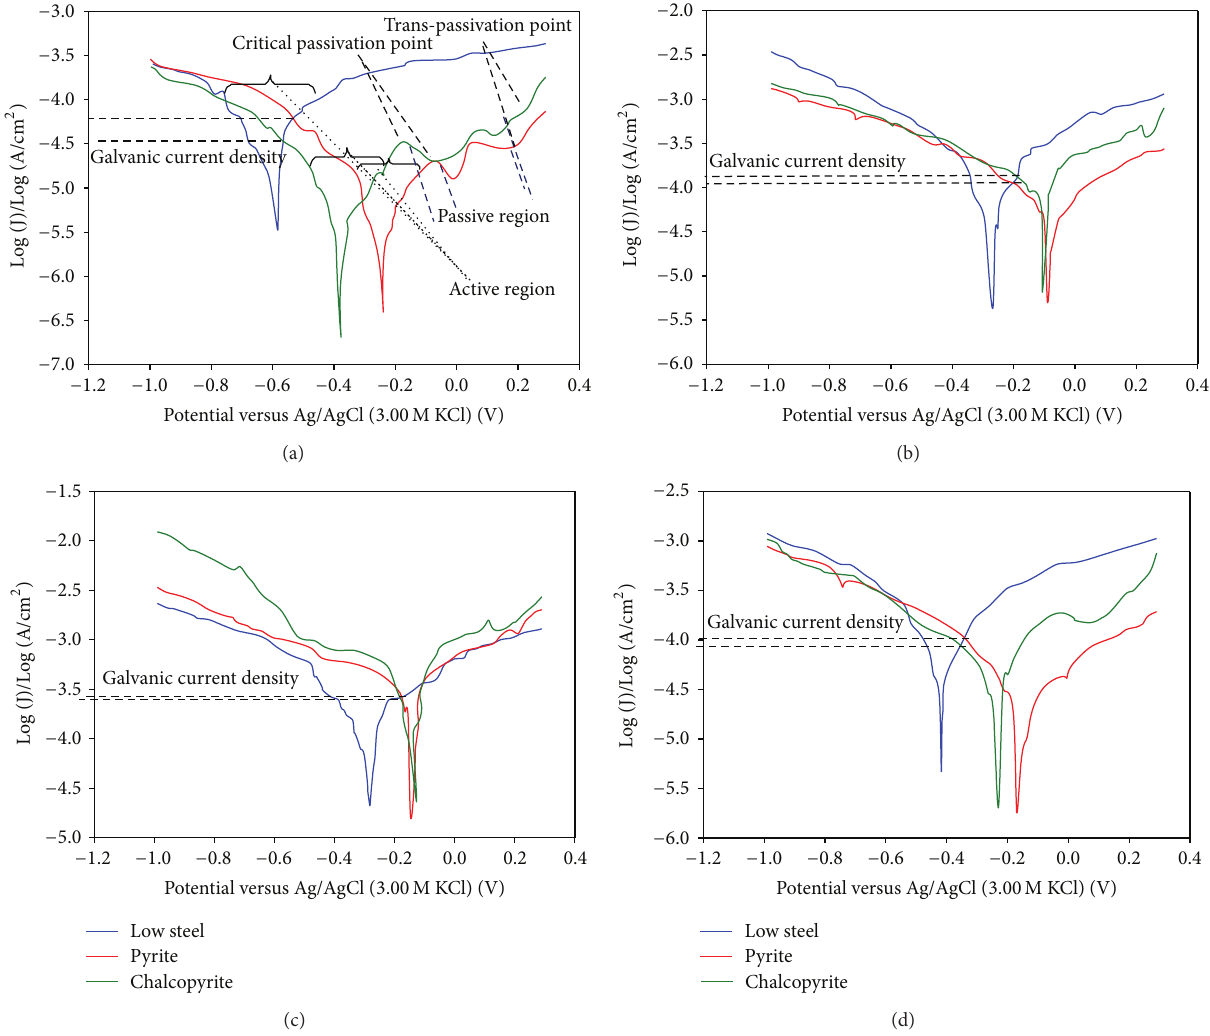
Figure 2: Potentiodynamic polarization sweep curves of grinding medium, pyrite, and chalcopyrite during grinding of ore with low alloy steel ball under nitrogen (a), air (b), and oxygen atmosphere (c), and without aeration (d) at a sweep rate of 50mV/ s